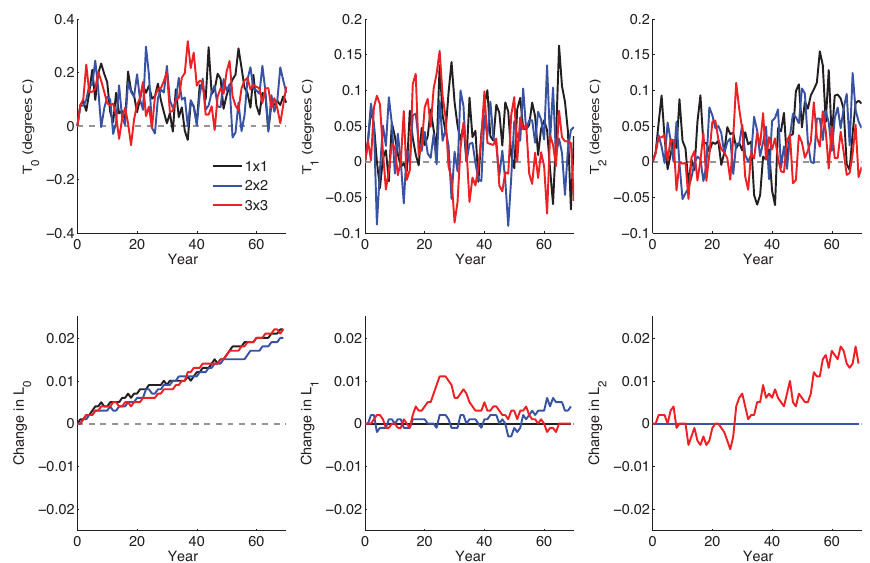
Figure 21. Same as Fig. 17 but for GISS ModelE2 (the evaluation model). Note different axis scaling in the top row.